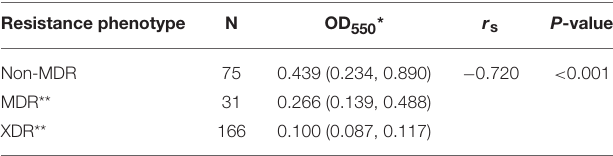
( r s = − 0.720, P < 0.001; Table 1 , Figure 2C ), indicating